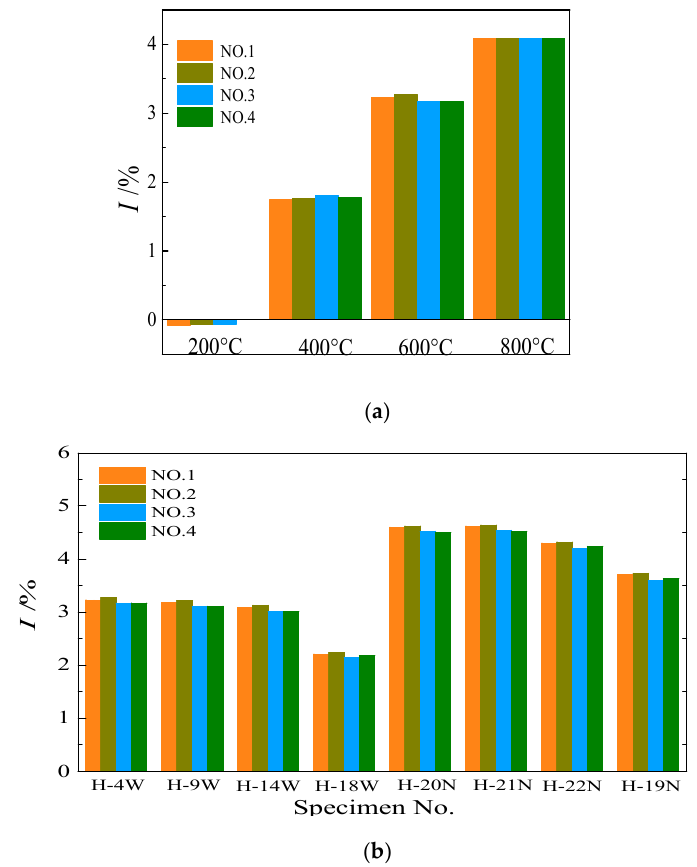
Figure 6. The mass loss rate of specimens exposed to water-cooling ( a ) the effect of temperature (60 MPa); ( b ) the effect of cooling methods (600 °C). Table 5. Concrete strength exposed to elevated temperatures and water-cooling